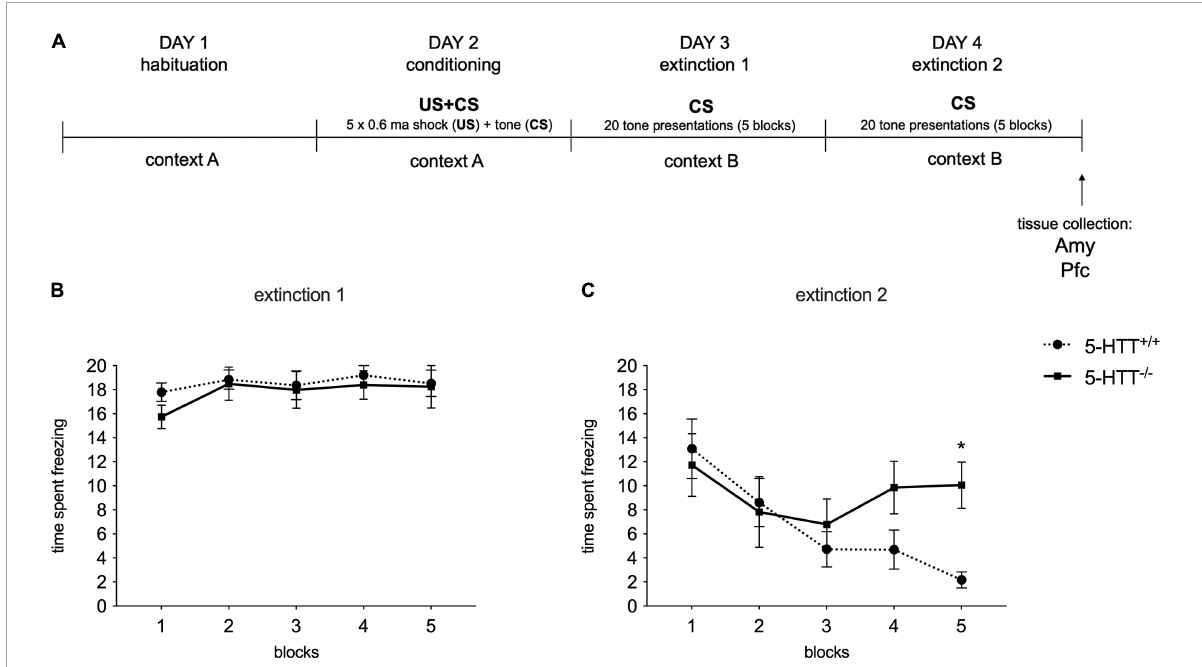
FIGURE2 Fear conditioning behavioral results during the extinction recall sessions. (A) Schematic representation of the experimental paradigm. (B,C) The data are expressed as the mean of the time spent freezing during conditioned stimulus presentations ± SEM of 10 independent determinations. * p < 0.01 vs. 5-HTT + / + (Two-way Anova with repeated measures). Amy, amygdala; Pfc, prefrontal